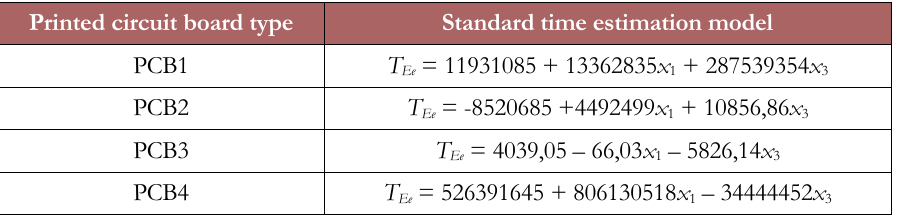
Table 14. Non-linear optimization models to estimate standard times. Case study: PCB